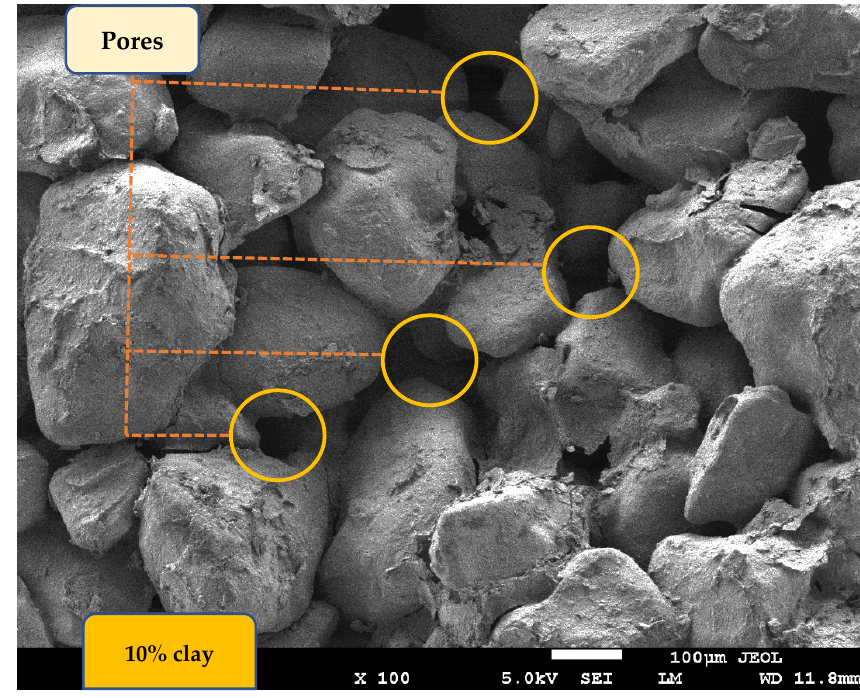
Figure 11. SEM of sand clay mixture with 10% clay content.